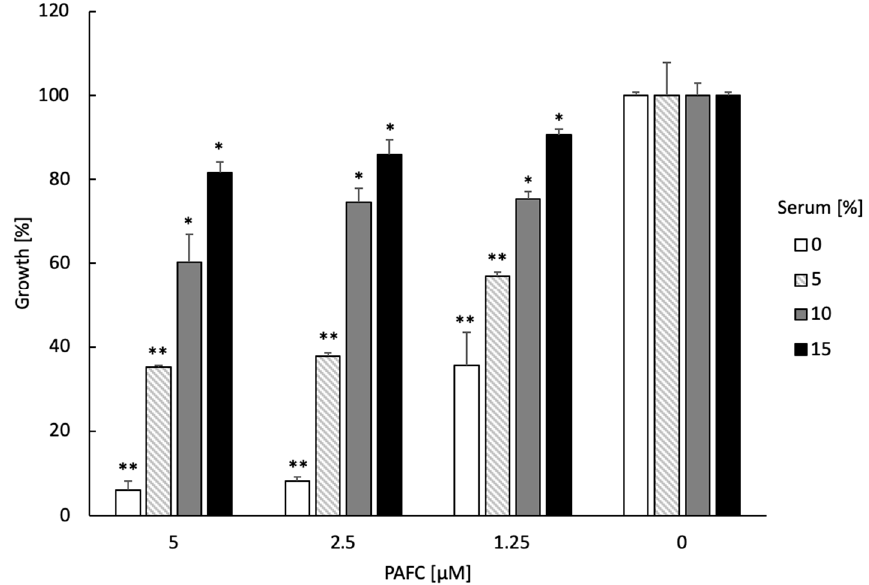
Figure 8. Serum sensitivity of PAFC. The activity of 0.5 × IC 90 (1.25 µ M), 1 × IC 90 (2.5 µ M) and 2 × IC 90 (5.0 µ M) PAFC was tested on C. albicans fluS in the presence of increasing concentrations (0–15%) of inactivated fetal calf serum in a microdilution broth assay. Candida cells without PAFC treatment (0 µ M) were used as control representing 100% growth in the presence of 0–15% serum. The mean ± SD (technical triplicate of one representative experiment out of two biological replicates) is shown. A two-sample Student’s t-test was applied to calculate the significant difference between the serum-treated samples compared to the untreated growth control (* p ≤ 0.05 and ** p ≤ 0.005).